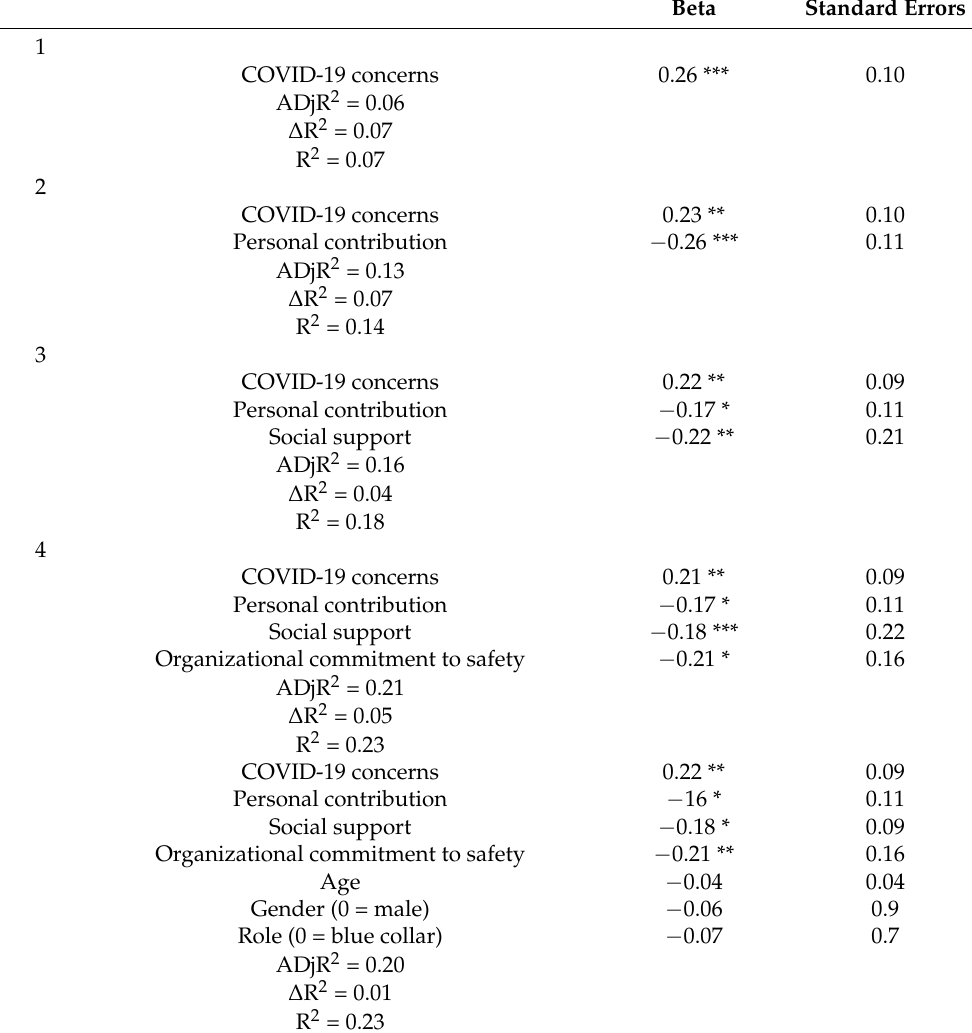
Table 2. Regression parameters: standardized coefficients and overall changes in R 2 for